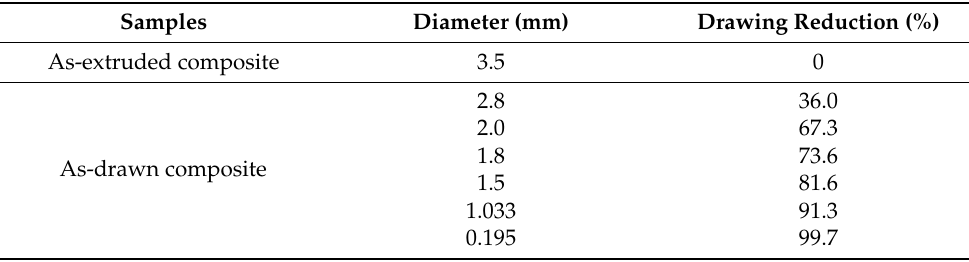
Table 1. The diameter and drawing reduction of the